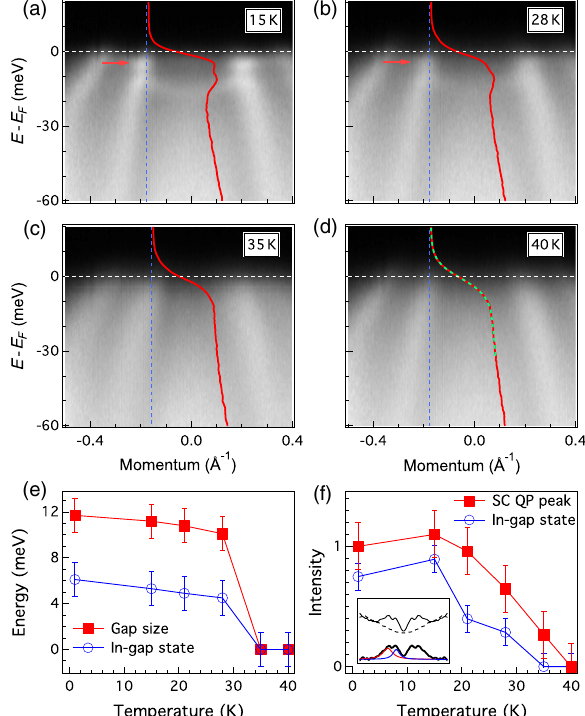
FIG. 2. (a) – (d) Temperature evolution, from (a) 15 K to (d) 40 K, of the ARPES intensity plots for the cut presented in Fig. 1(a). The red arrows indicate the in-gap states. The EDCs at k F are also displayed in red. The EDC in (d) does not show any in-gap state, as suggested by a fit (in green) to the Fermi-Dirac function convoluted with the resolution function. (e) Temperature evolution of the SC-gap amplitude (red) and the position of the in-gap-state peak, as determined from EDC analysis. (f) Temper- ature dependence of the spectral weight of the SC coherent peak (red) and in-gap-state peak at k F , as determined from EDC analysis. The intensity is normalized to the area under the fit curve of the SC quasi-particle (QP) peak at 1 K. The inset illustrates how the spectral weight is extracted. After symmetriz- ing the EDCs to approximately remove the Fermi cutoff and removing a background shown by a dashed line, we fit the left part of the subtracted symmetrized EDC using two Lorentzian curves. The spectral weight is given by the area below each Lorentzian